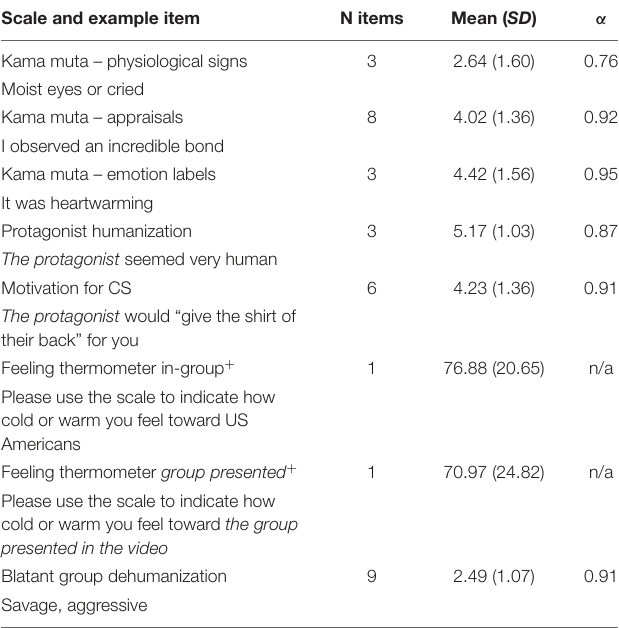
TABLE 1 | Descriptive statistics and example items for measures used in Study